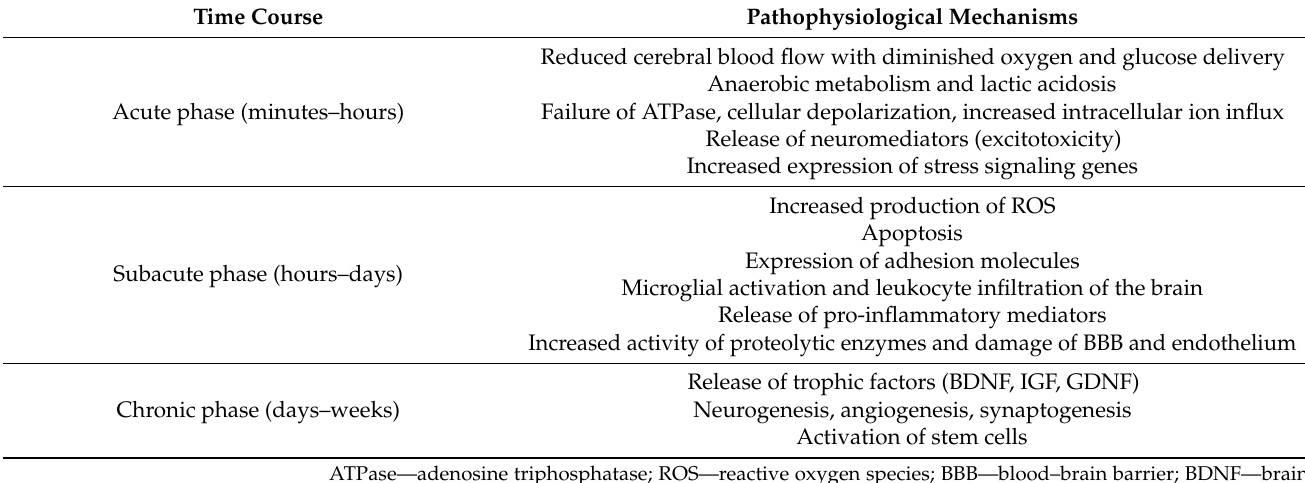
Table 1. Pathophysiology of cerebral ischemia and reperfusion